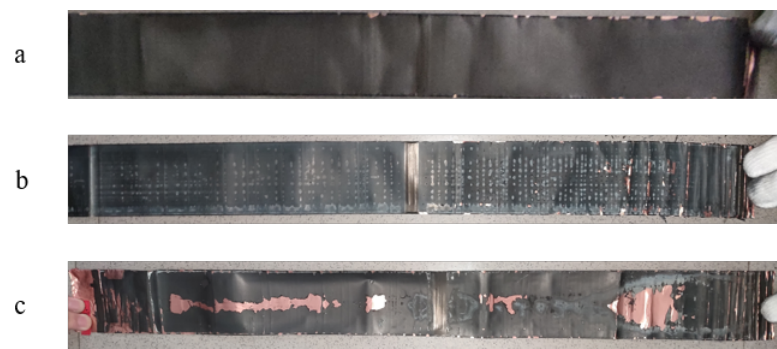
Fig. 3. The pictures of negative electrode surfaces: (a) Fresh battery; (b) Battery #1; (c) Battery